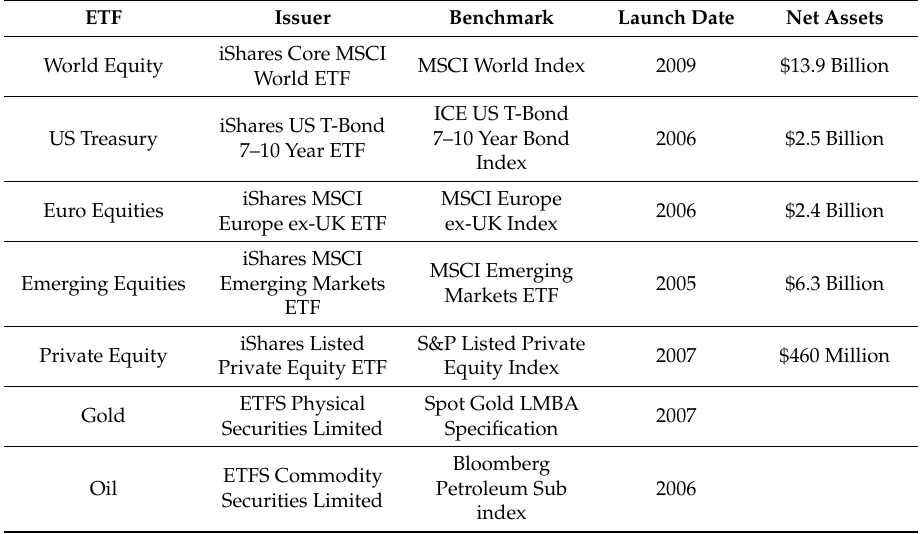
Table 1. Exchange-traded funds (ETFs) Descriptions.